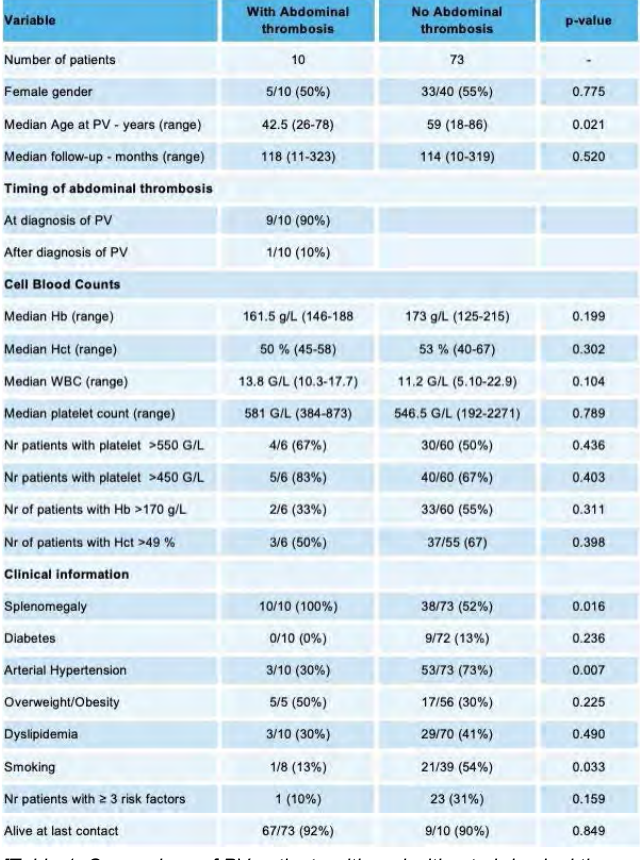
[Table 1. Comparison of PV patients with and without abdominal throm-